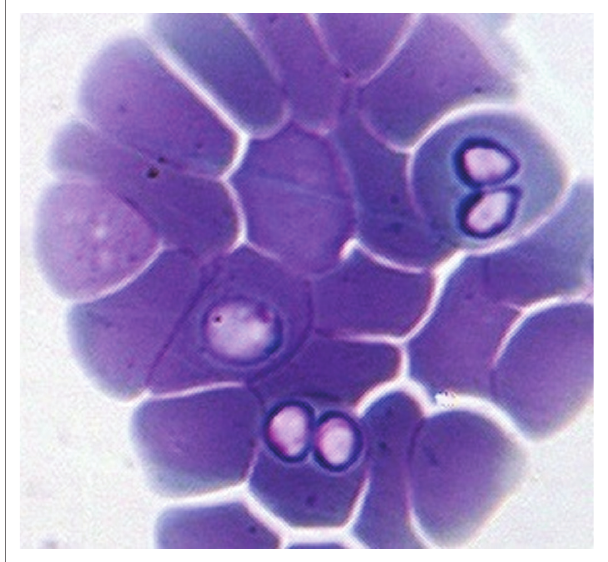
FIGURE 1: A single Babesia vogeli trophozoite and two pairs of merozoites on a blood smear made at Windhoek Animal Hospital from a dog presented with clinical signs of